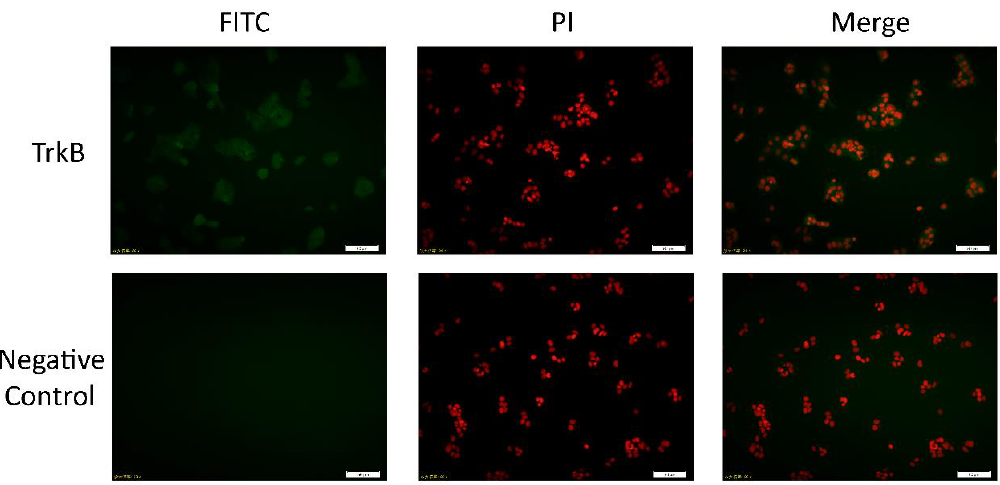
Figure 1. Determination of TrkB protein in Ishikawa cells by cell immunofluorescence. The Ishikawa cells were incubated with anti-TrkB or primary antibody dilution (negative control), then coupled with FITC-conjugated secondary antibody (FITC; green) and propidium iodide (PI; red) for the detection of nuclei. The picture (merge) was the result of the merging between the two fluorescences. Scale bar = 50 µ m. TrkB: tyrosine kinase receptor β